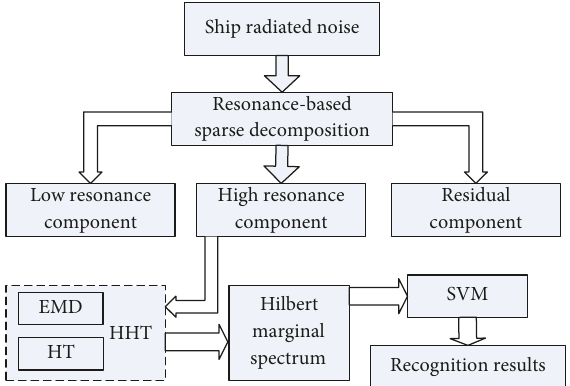
Figure 1: Overview of the proposed